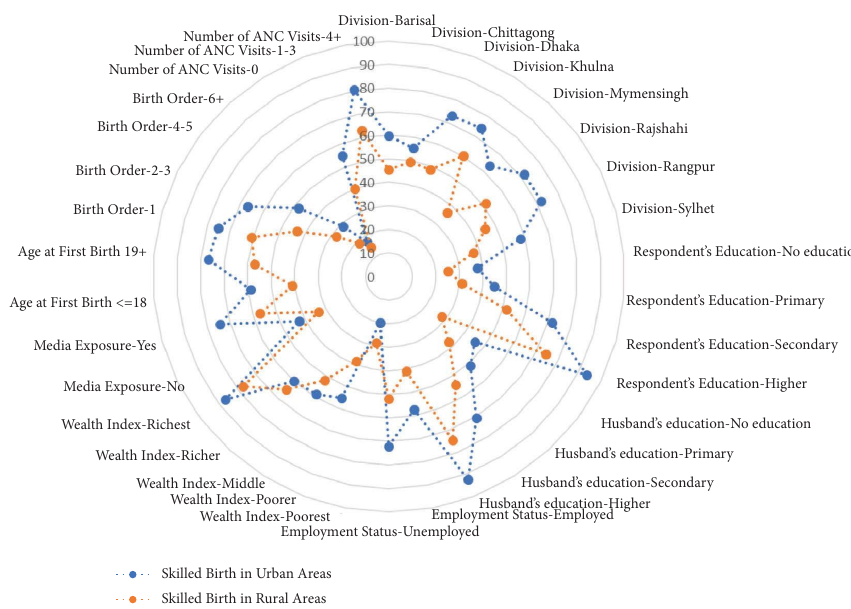
Figure 2: Prevalence of skilled birth attended in terms of urban and rural area in Bangladesh (radar plot).